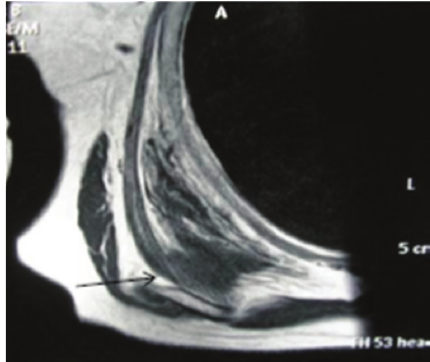
F 1: Axial MRI image indicating a hypointense rather round mass with signal intensity almost equal to surrounding muscles.